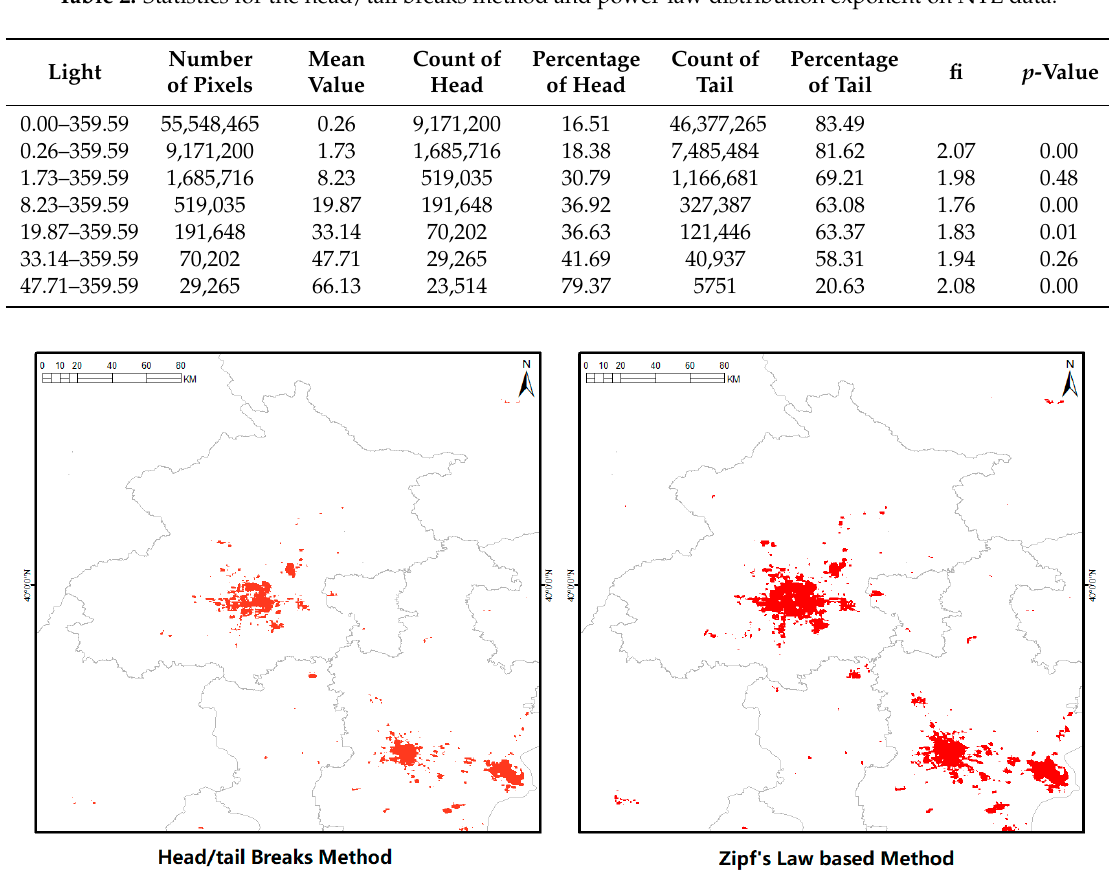
Table 2. Statistics for the head/tail breaks method and power-law distribution exponent on NTL data.